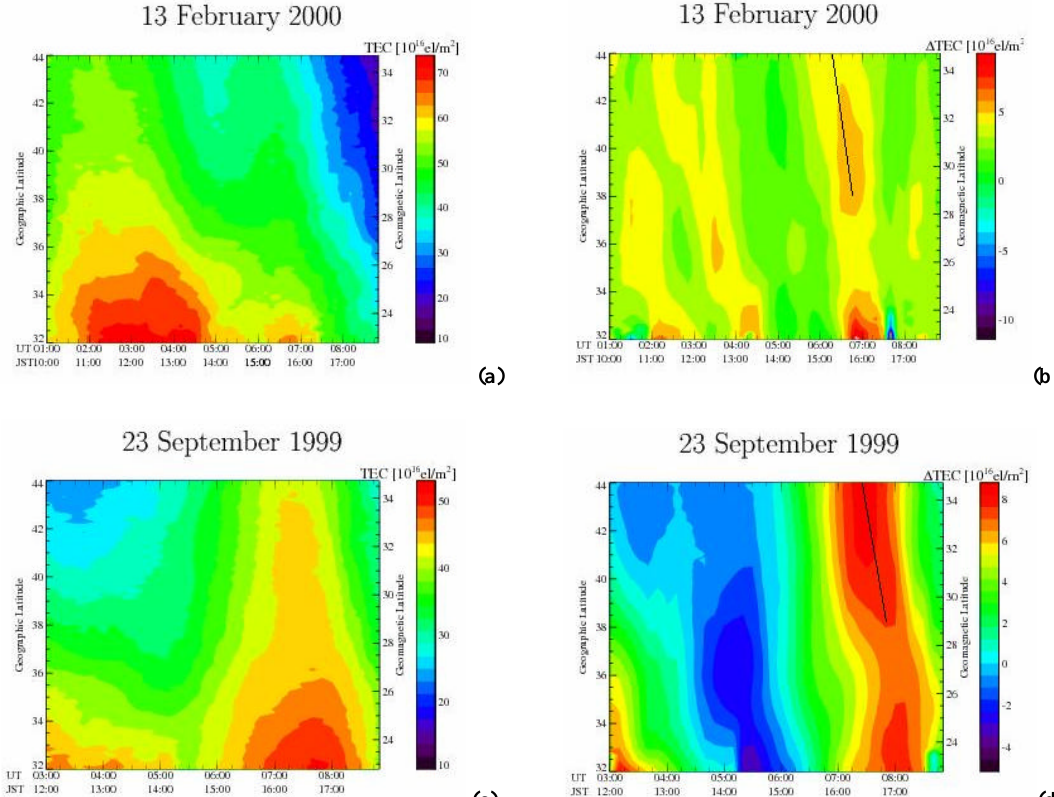
Fig. 3. The contours for latitudinal and temporal variations of (a) TEC and (b) the perturbation component of TEC on 13 February 2000. The same parameters (TEC and the perturbation component of TEC) are also plotted on the other storm days, such as, 23 September 1999: (c) and (d) , respectively, 29 October 2003: (e) , (f) , respectively, and 21 November 2003: (g) and (h) , respectively. In Fig. 3b, the black line drawn with the slope=0.0043deg/s indicates the southward movement of the perturbation component on 13 February 2000. Similarly, the southward movement of the perturbation component on 23 September 1999 (Fig. 3d), 29 October 2003 (Fig. 3f), and 21 November 2003 (Fig. 3h), are indicated by black lines with the slopes 0.005, 0.0056, and 0.0066deg/s,